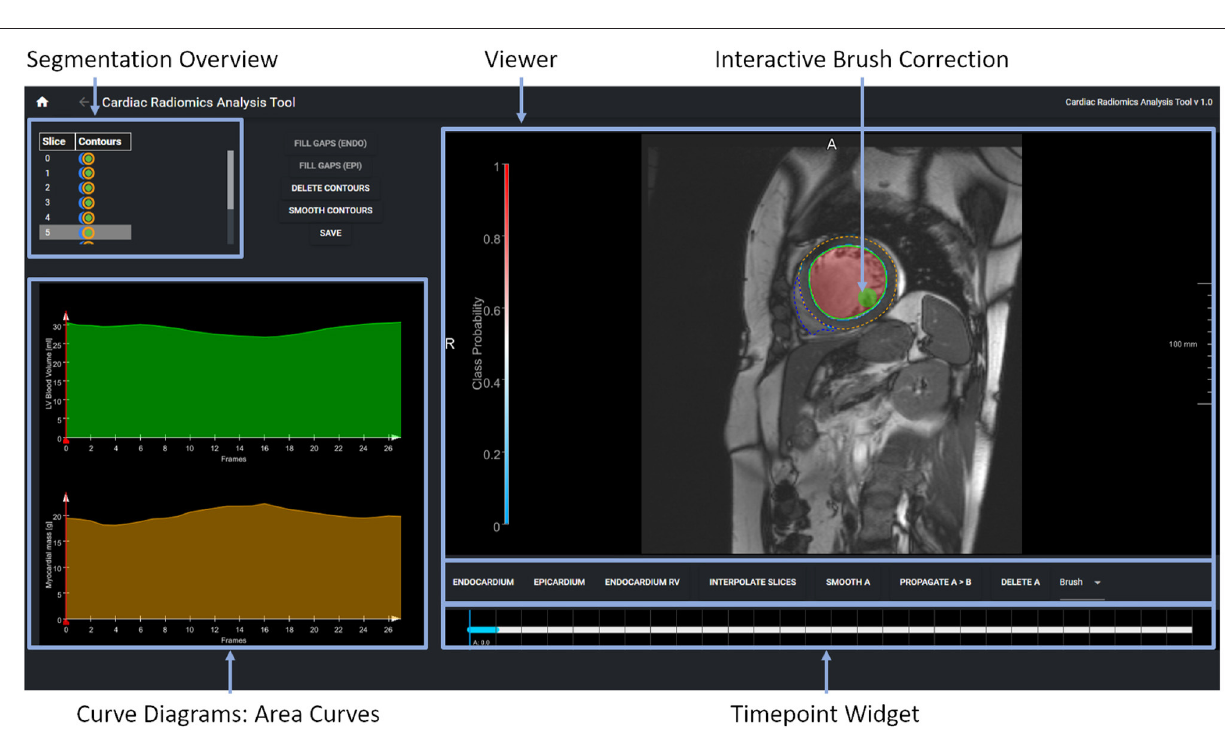
and an abnormal right ventricle (RV). The dataset contains the same number of cases in each subgroup. Clinical